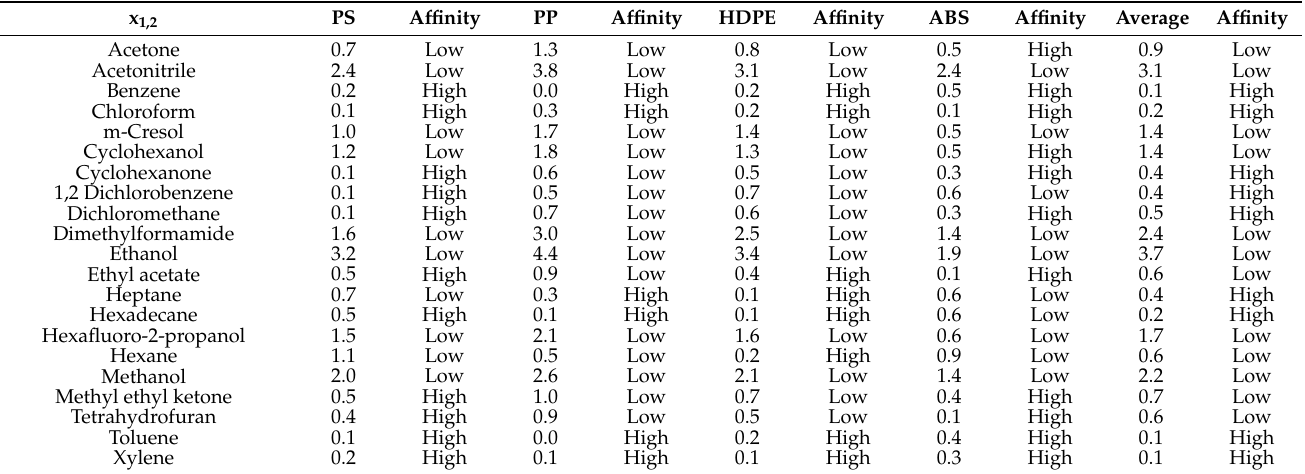
Table 3. Affinity of plastic solubility in various solvents using the Flory–Huggins